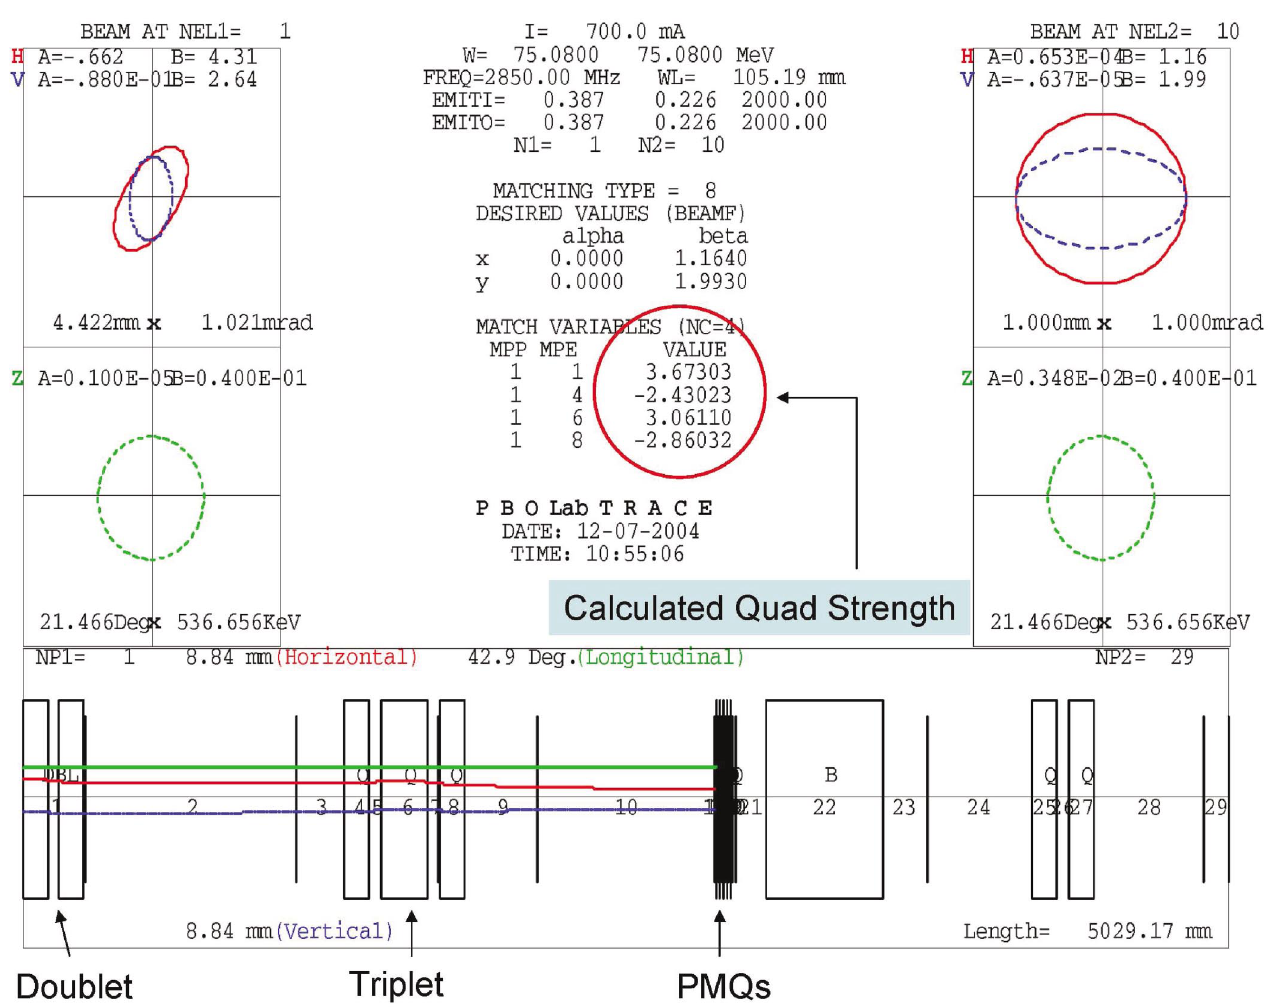
FIG. 19. (Color) TRACE3D (screen shot) model of the beam line used to compute the focusing strength of the upstream EM quads for proper matching into the